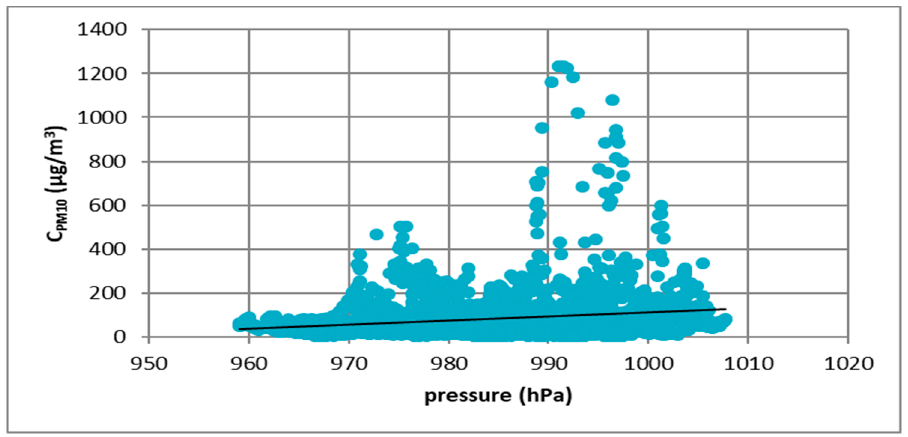
Figure 9. The e ff ect of atmospheric pressure on PM10 concentration in Zabrze in